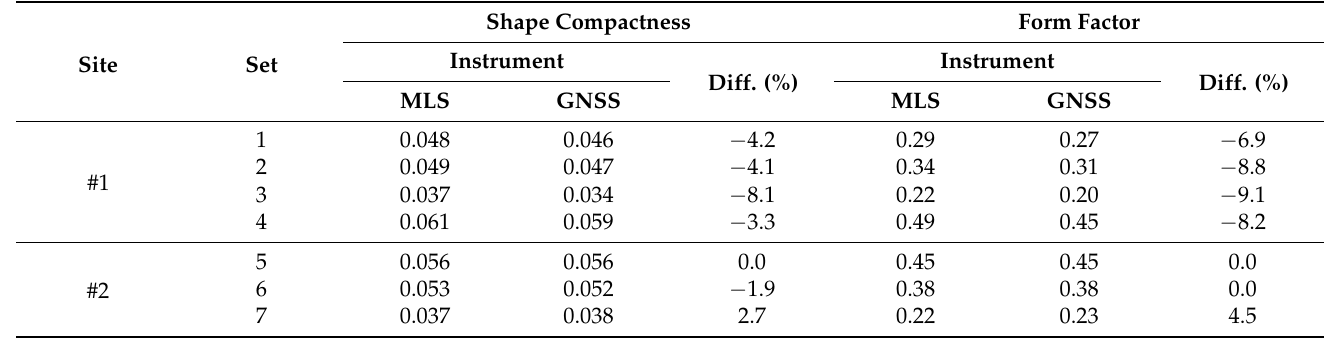
Table 4. The shape compactness and form factor of the convex hulls, including the points for the 14 datasets. Relative differences (diff.) between the two instruments are shown in percent.